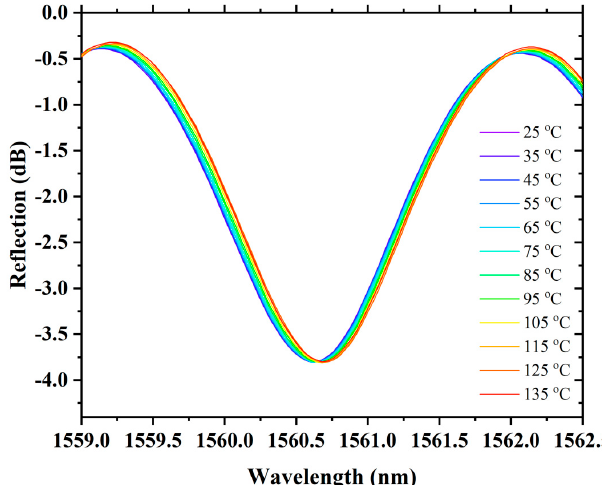
Figure 13. Spectral evolution of the proposed sensor with temperature rise.